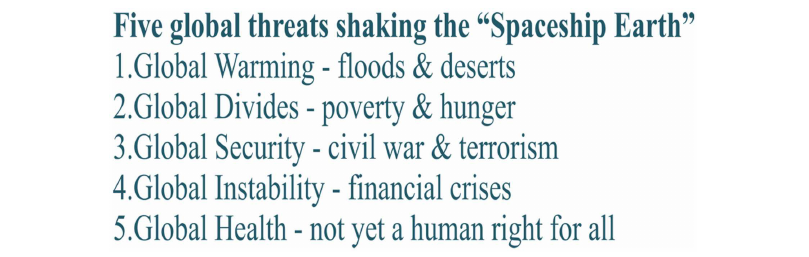
FIGURE 1 | Core global threats of twenty-first century